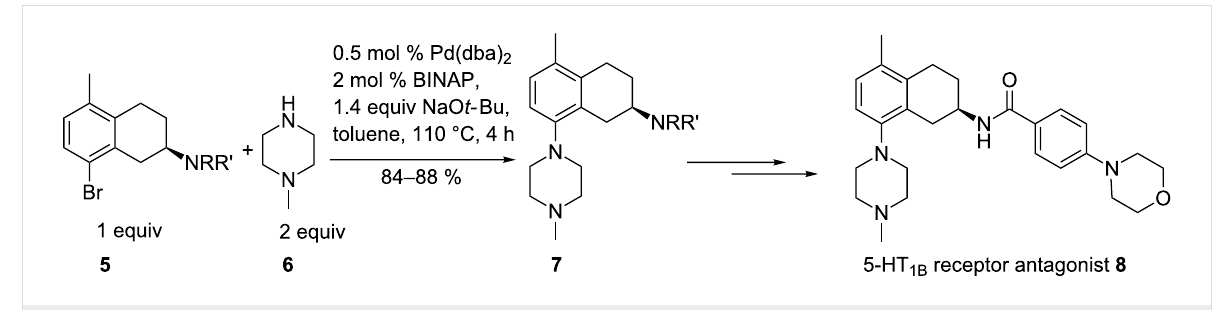
Scheme 2: Synthesis of a novel 5-HT 1B receptor